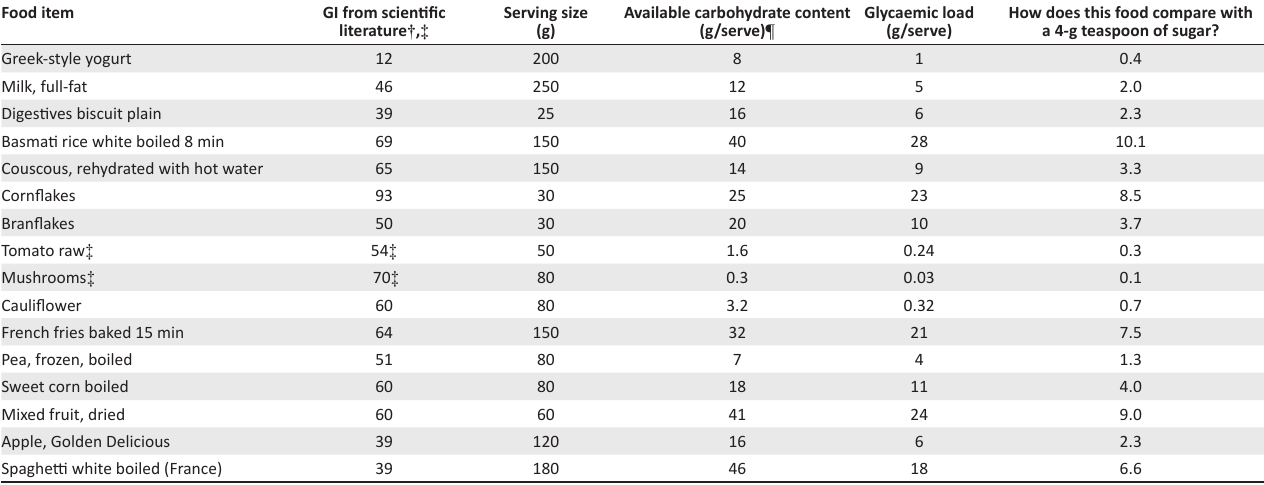
TABLE 1: Glycaemic load of some standard food portions as 4 g table sugar equivalents. Food